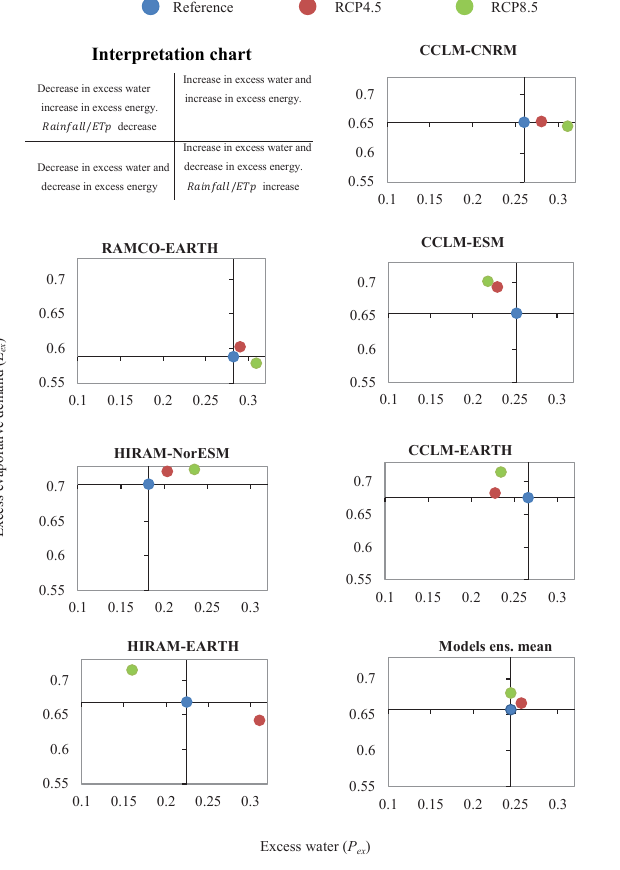
Figure 11. Plot of excess precipitation ( P ex ) vs. evaporative de- mand ( E ex ) for the reference period (1979–2000) and emission sce- narios RCP4.5 and RCP8.5 (2021–2050) for the RCM–GCM en- semble. The shift in RCP dots compared to the reference period’s dot indicates the effects of climate change on the catchment hydrol- ogy. P ex and E ex for each period are calculated from the annual average rainfall, potential evapotranspiration, and actual evapotran-